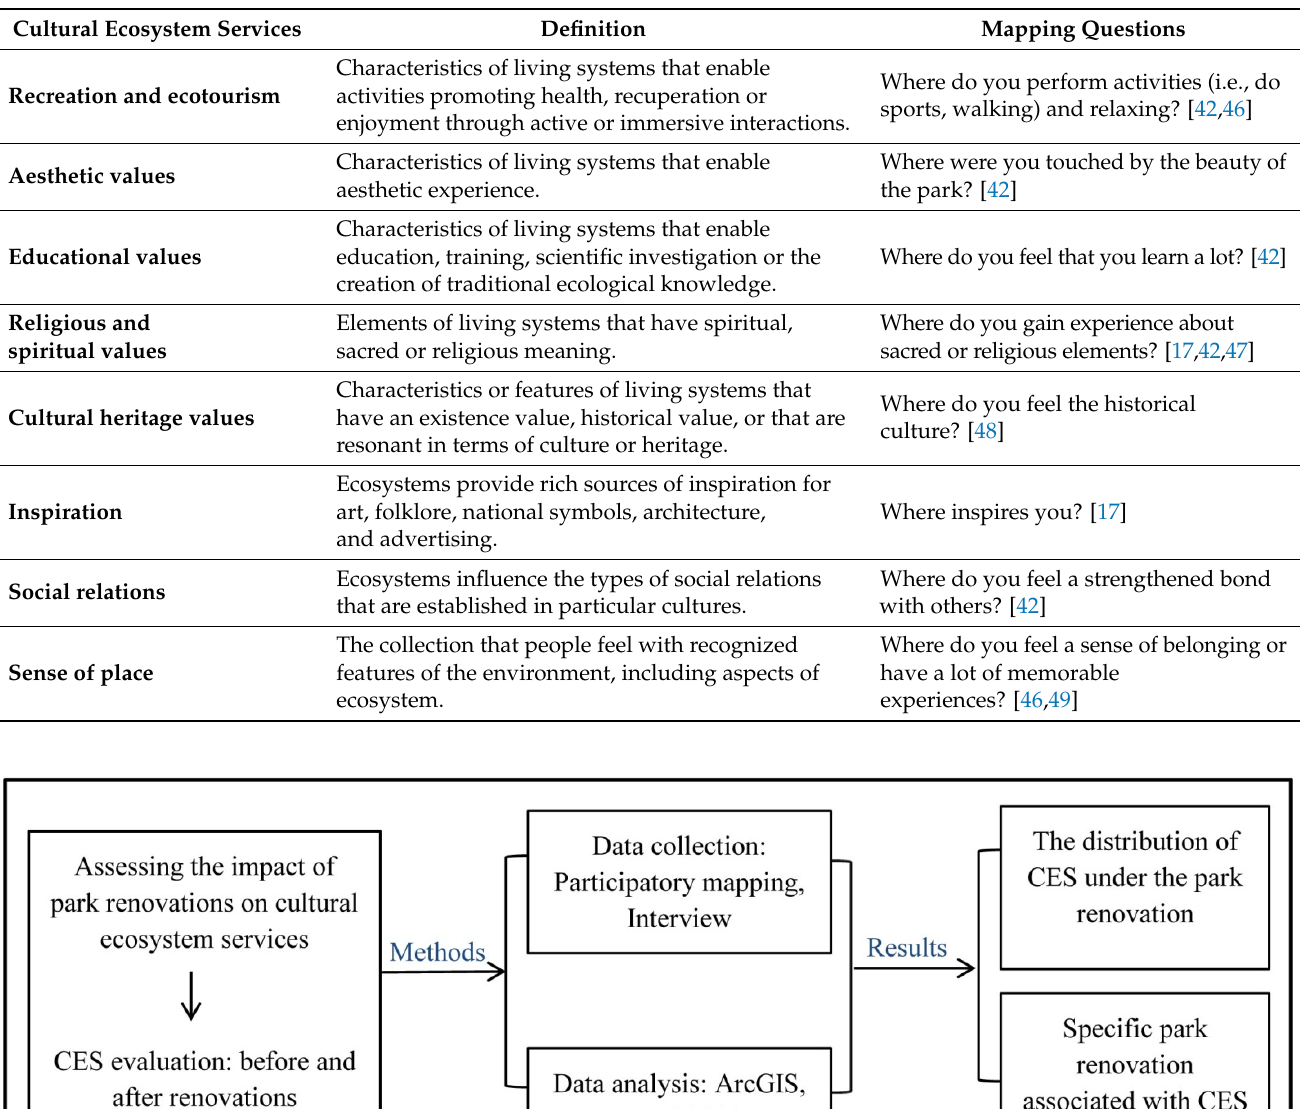
Table 2. Selected cultural ecosystem services and their definitions [1], and corresponding mapping questions as used in this study.